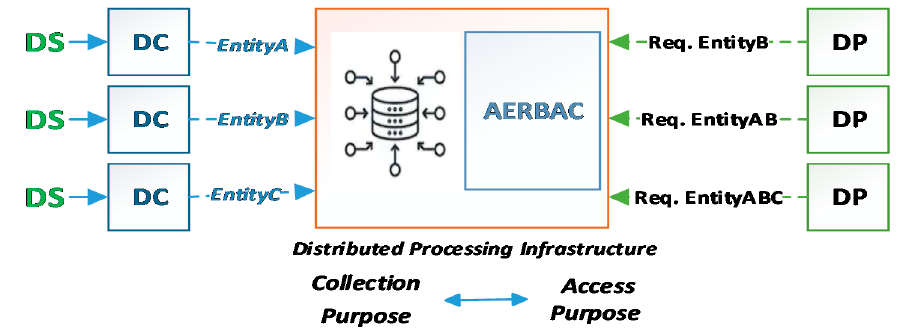
Figure 4. Provenance-enabled access control model.